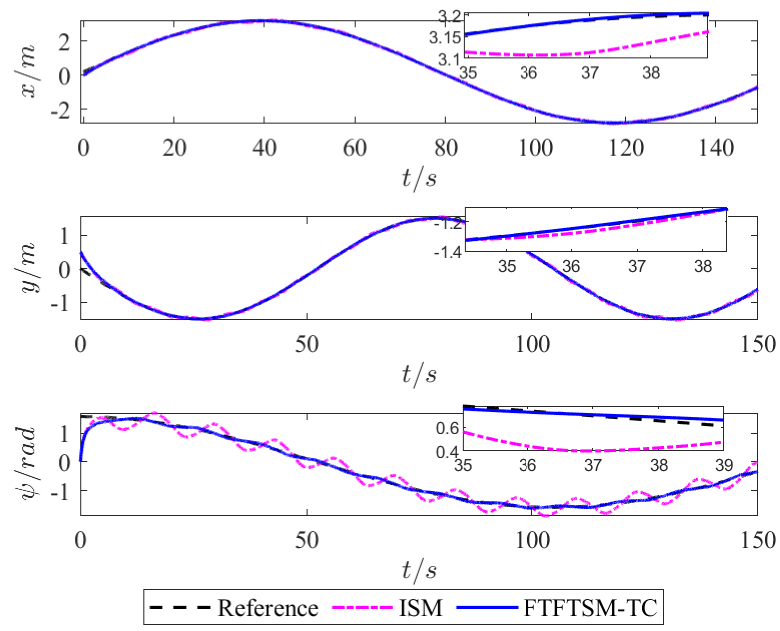
Figure 4. Position tracking of FTFTSM-TC and